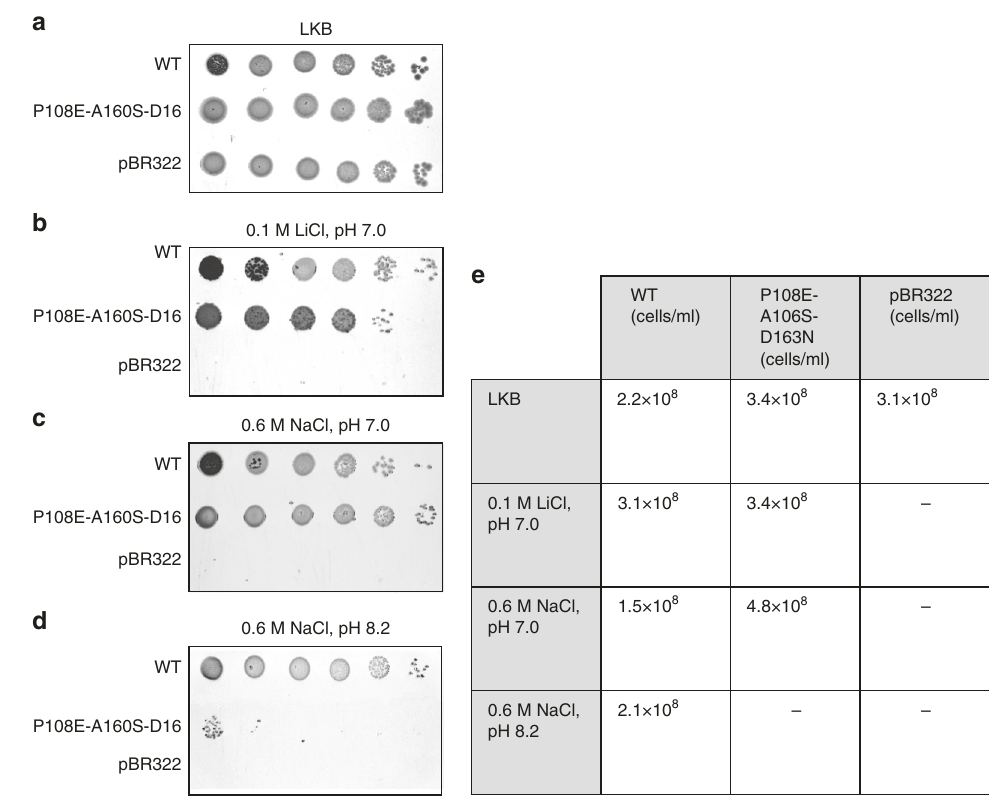
Fig. 5 The NhaA triple mutant supports cell growth under neutral but not alkaline pH. EP432 E. coli , carrying deletions of both nhaA and nhaB genes, was transformed with EcNhaA, either WT or the P108E_A160S_D163N triple mutant, or an empty pBR322 vector, as negative control. Growth resistance to Na + /Li + was performed as described in Methods section. a Cells were grown in modi fi ed L broth (LBK, with NaCl replaced by KCl) and then b – d tested for growth resistance to Li + and Na + . e A summary of the number of cells grown under each condition. The standard deviation was 3 –